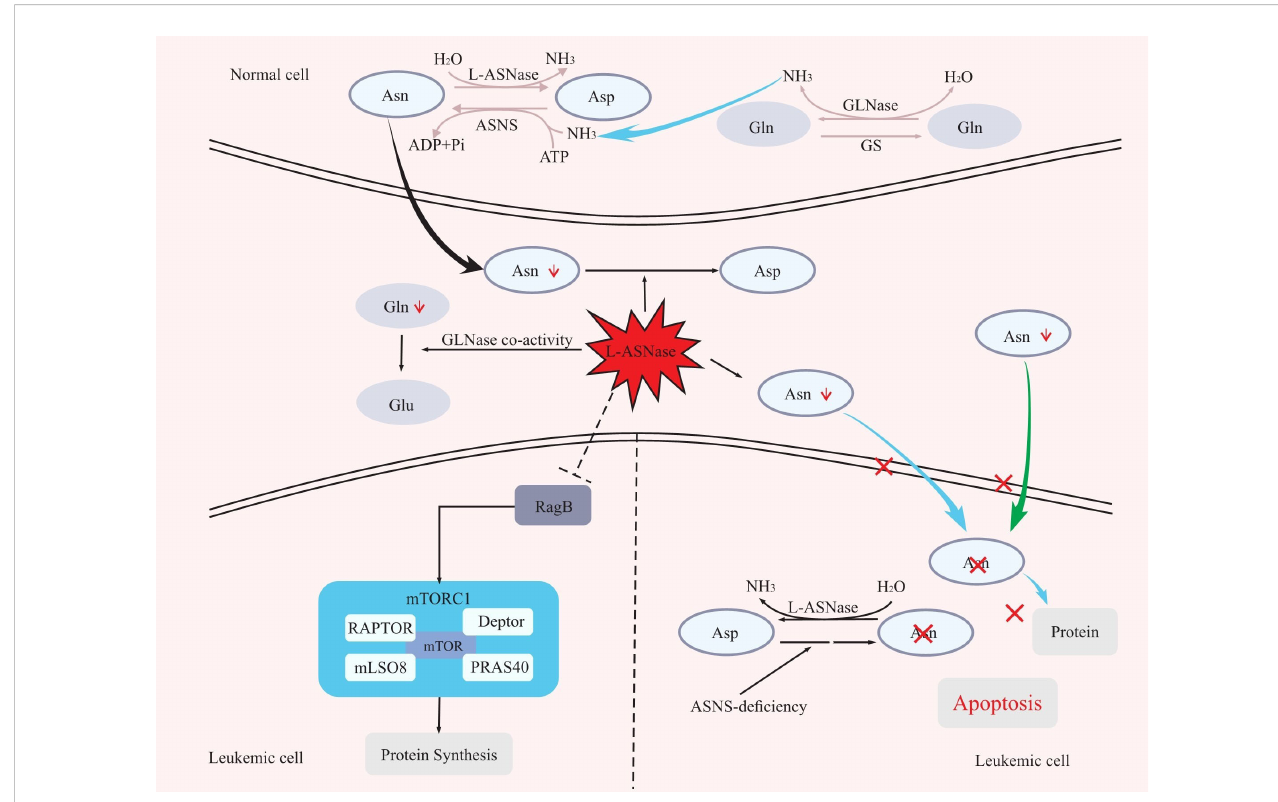
FIGURE 1 The mechanism of L-ASNase. L-ASNase depletes Asn, and GLNase coactivity hydrolyzes Gln, which further reduces Asn, leading to apoptosis of leukaemia cells. L-ASNase can inhibit RagB-mTORC1 and thus inhibit protein synthesis. Asp, aspartic acid; Asn, asparagine; Gln, glutamine; Glu, glutamic acid; ASNS, asparagine synthetase; L-ASNase, L-asparaginase; GS, glutamine synthetase; GLNase,